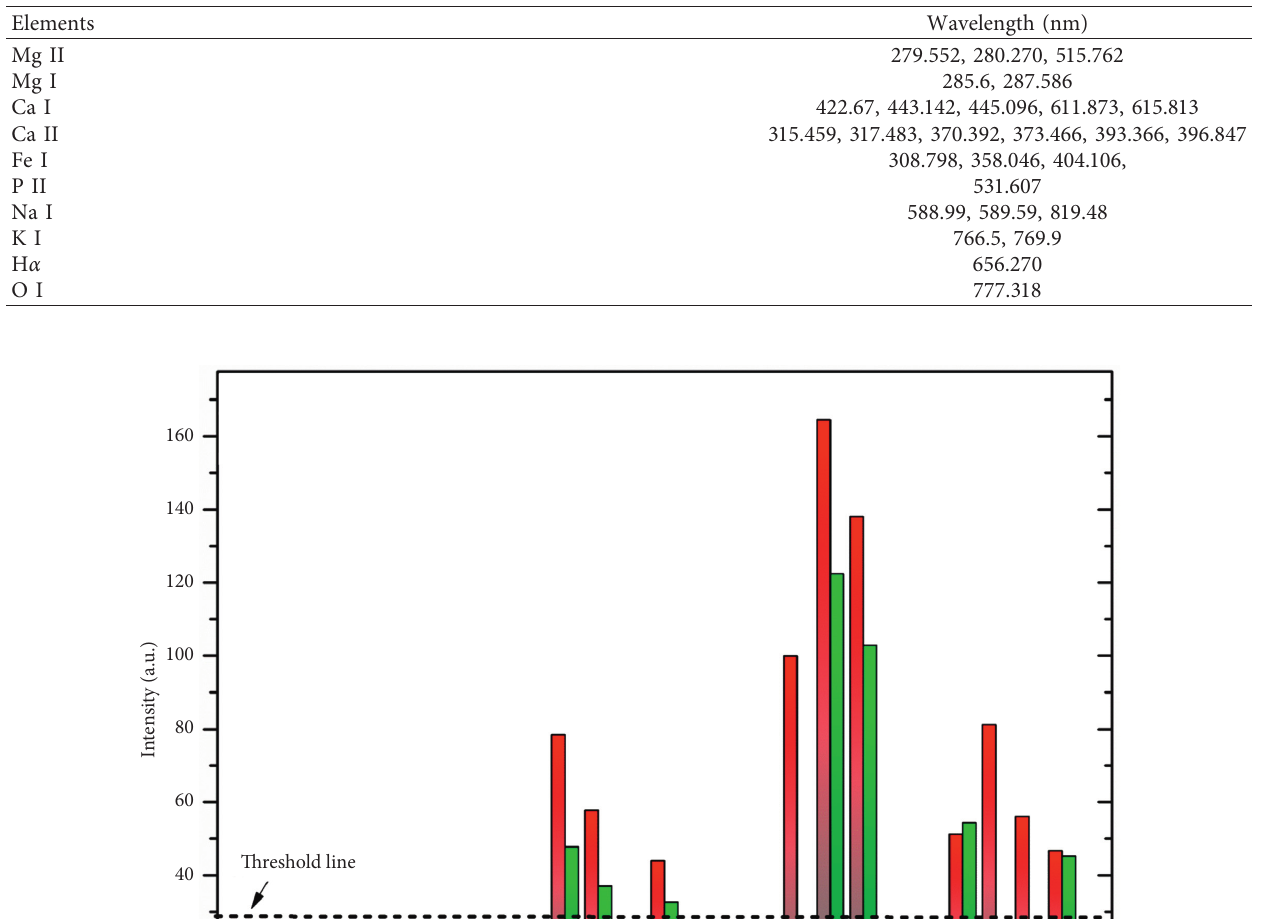
Table 1: The selected atomic and ionic emission lines.